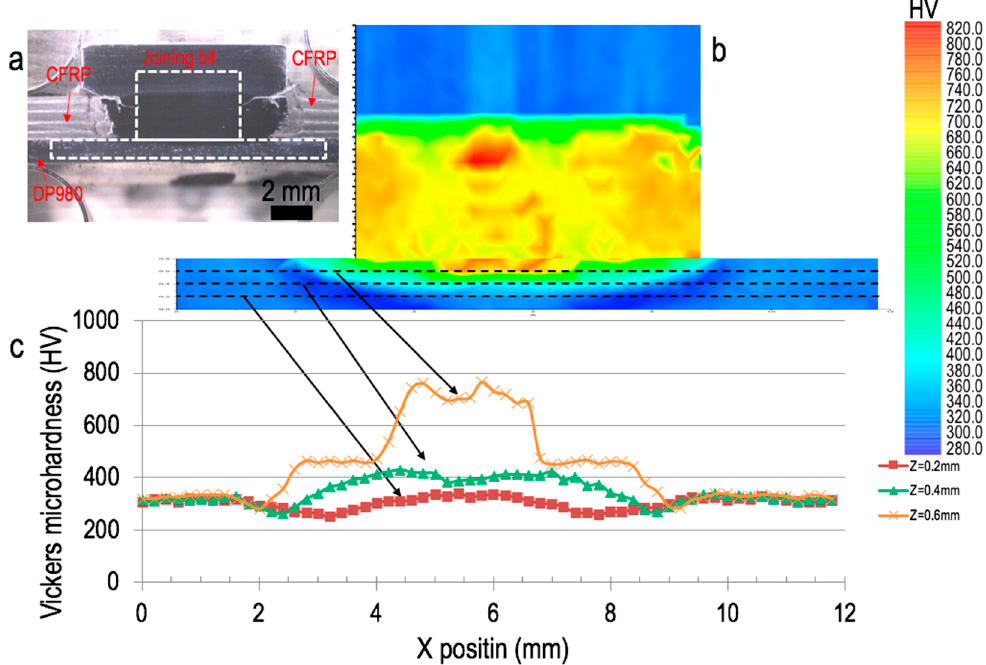
Figure 9. ( a ) Cross-sectional view of FBJ specimen; ( b ) Vickers microhardness mapping at cross section of FBJ specimen; ( c ) Vickers microhardness profile along the x direction.